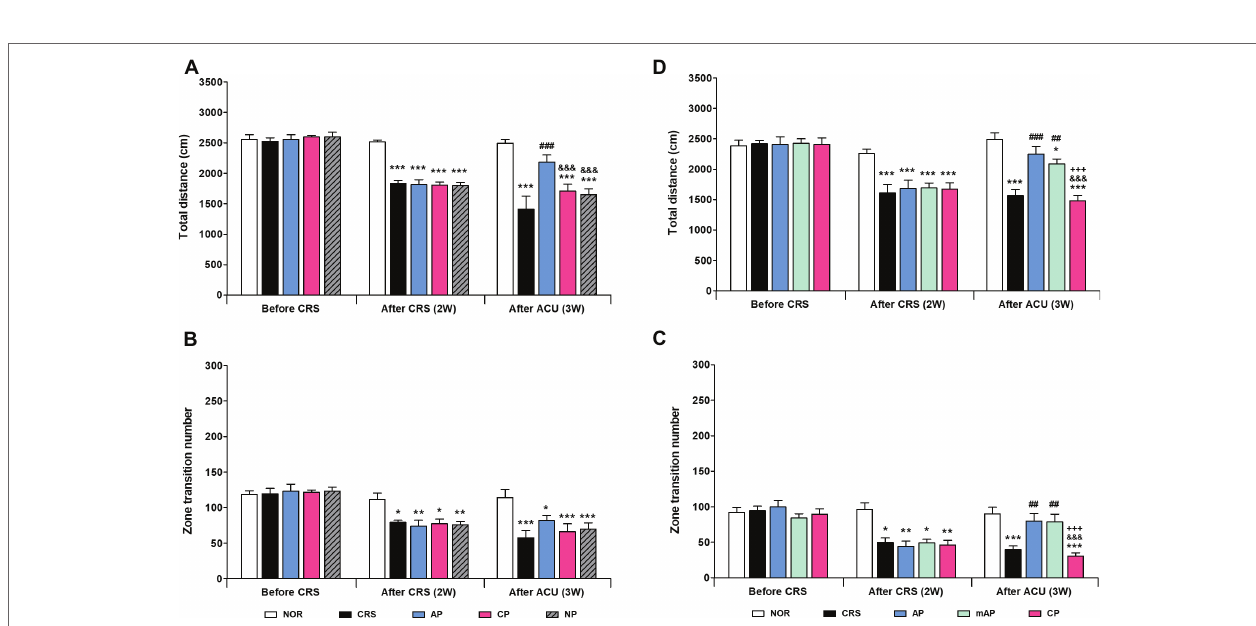
FIGURE 3 | Acupuncture treatment at AP (KI10·LR8·LU8·LR4) and mAP (KI10·LR8) can reverse chronic restraint stress (CRS)-induced depressive-like behavior. (A,B) Acupuncture treatment at AP (KI10·LR8·LU8·LR4) significantly reversed the decrease in the total distance and the number of zone transitions caused by CRS (AP vs. CRS, CP, and NP treatment groups). Acupuncture treatment at AP and mAP significantly reversed the decrease in the total distance and the number of zone transitions compared to the CRS and CP treatment groups (C,D) . NOR, normal; AP, CRS and acupuncture treatment at KI10·LR8·LU8·LR4; mAP, CRS and acupuncture treatment at KI10·LR8; CP, CRS and acupuncture treatment at LU8·LR4·HT8·LR2; NP, CRS and acupuncture treatment at non-acupoints on the hips. * p < 0.05, ** p < 0.01, *** p < 0.001 vs. NOR. ## p < 0.01, ### p < 0.001 vs. CRS. &&& p < 0.001 vs. AP. +++ p < 0.001 vs. mAP. Two-way ANOVA followed by the Bonferroni test. Error bars indicate